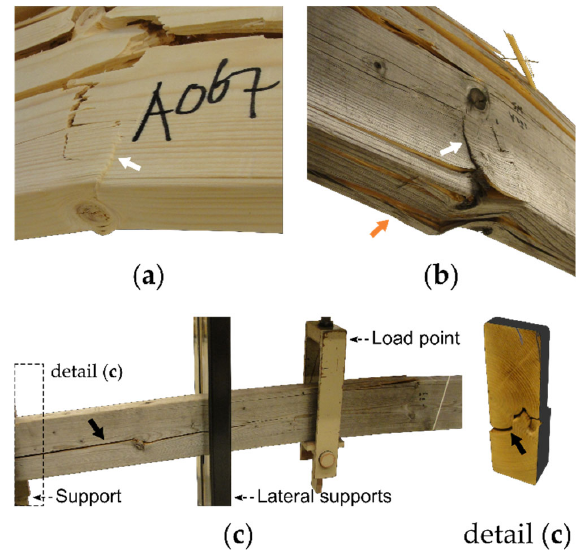
Figure 11. Example of failures: ( a ) control board directly tested, ( b ) control board tested after exposure and ( c ) TM board tested after exposure. Legend: white arrow = compression failure with fibre buckling; orange arrow = tensile failure perpendicular to the grain in the compression zone; black arrow = horizontal shear failure.